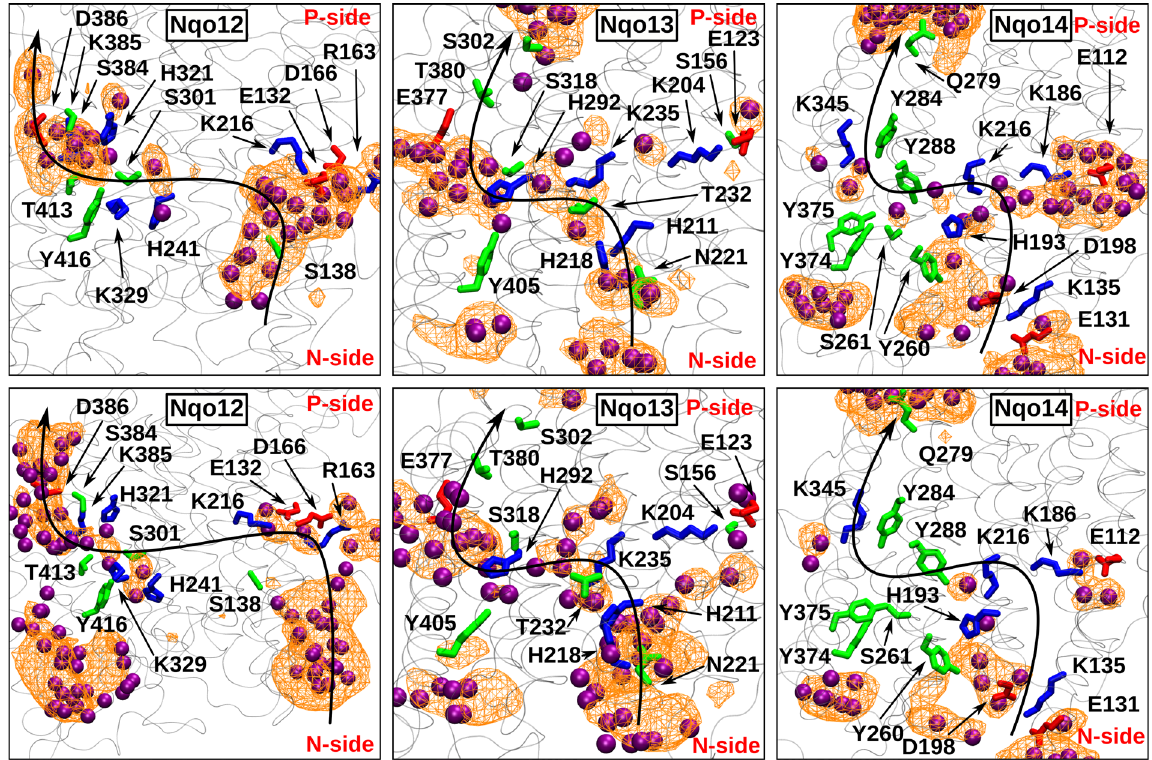
Figure 3. Proton channels in antiporter-type subunits Nqo12–14 from simulation setups I (top) and II (bottom) with Q ox and QH 2 , respectively (see also Table 1). The putative proton transfer paths from the N-side to the P-side are marked with an S-shaped black arrow. The residues that take part in water-wire formation are also listed (acidic – red, basic – blue, and polar - green). Water molecules are shown in purple. The water positions are instantaneous, and represent a simulation snapshot. The water occupancy, calculated by averaging water positions over entire simulation trajectory, is displayed as an orange mesh plotted with an isovalue of 0.1. Water molecules within 6 Å of selected residues (Supplementary Table S1) were used to calculate the occupancy